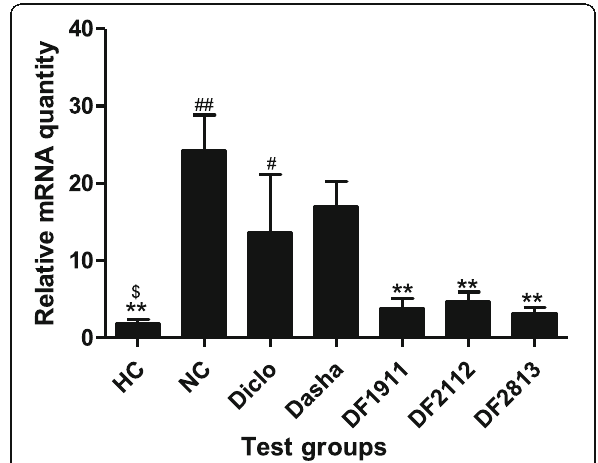
Fig. 4 Effect of formulations on the mRNA expression of IL1- β in inflamed paw tissue. HC: Healthy control, NC: Negative control, Diclo: Diclofenac sodium, Dasha: Dashamoola Kwatha , DF: Dashamoola Formulation. Values are expressed as Mean ± SEM ( n = 3). Comparisons were done between NC/HC and each individual treated group by Dunnett ’ s multiple comparison test. # = p < 0.05, ## = p < 0.01 when compared to HC; ** = p < 0.01 when compared to NC; $ = p < 0.05 when compared to Dasha